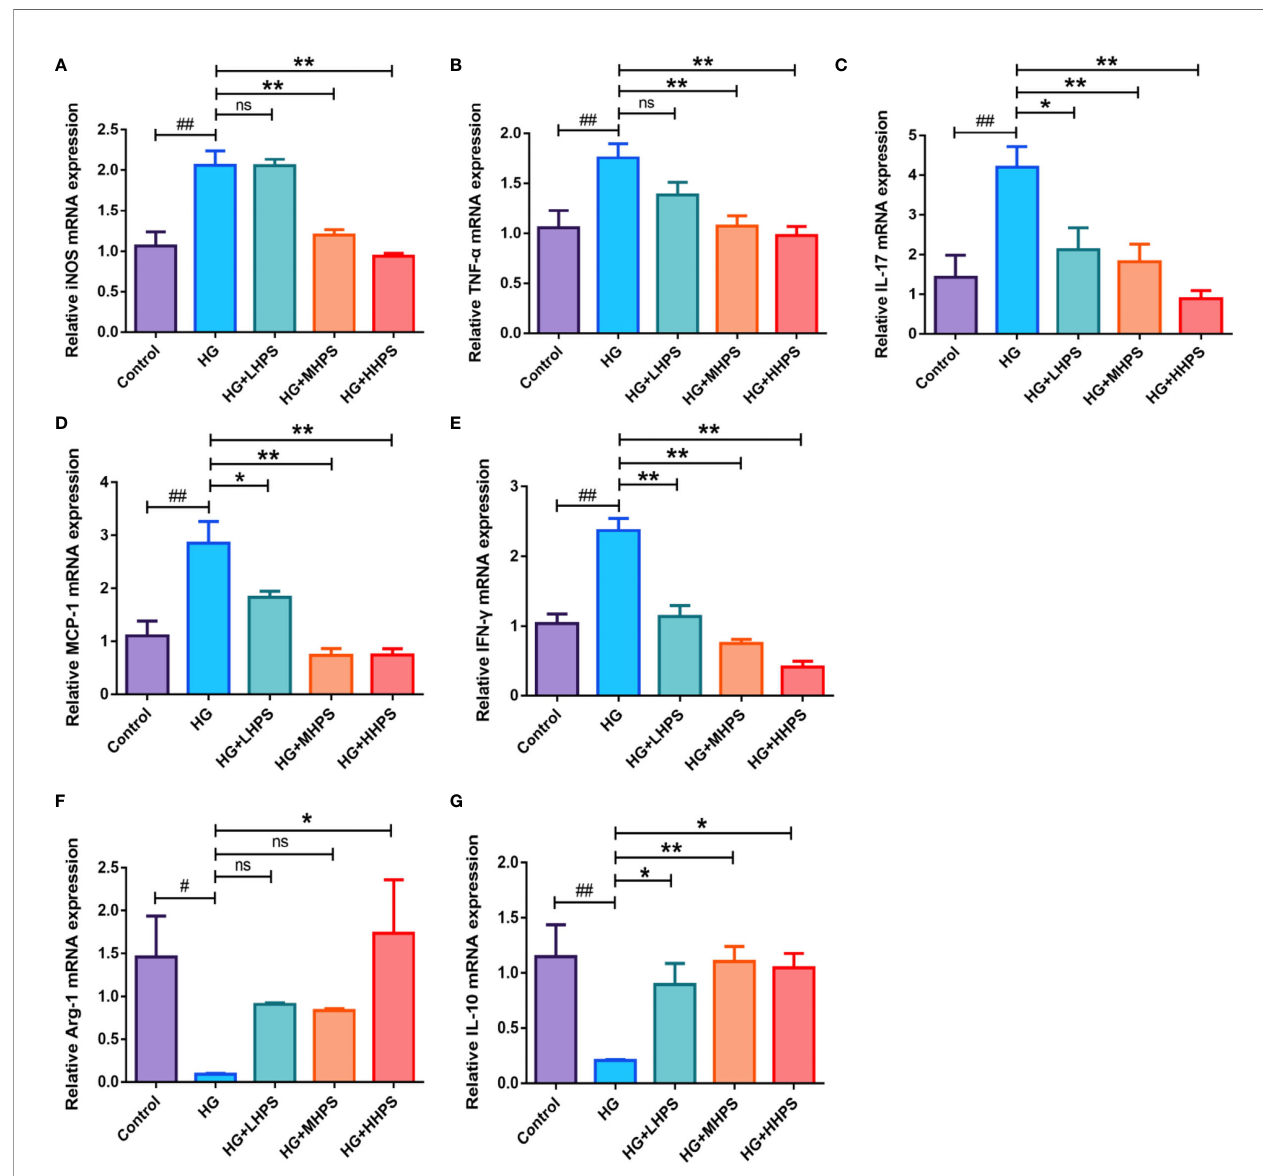
FIGURE 8 | Effects of Hyperoside on the gene expressions of the proin fl ammatory and anti-in fl ammatory cytokines in high glucose (HG)-induced BMDMs. BMDMs were treated with high glucose (35mM) for 48 hrs, followed by pretreatment with high-dose HPS (HHPS) (50uM) or low-dose HPS (LHPS) (12.5uM), and then related mRNA expression was determined by qRT-PCR. Relative mRNA expressions of the proin fl ammatory cytokines iNOS (A) , TNF- a (B) , IL-17 (C) , MCP-1 (D) and IFN- g (E) , and anti-in fl ammatory cytokines Arg-1 (F) and IL-10 (G) were shown. Values are presented as means ± SD with n = 5 per group. Differences between experimental groups were evaluated using ANOVA ( # P < 0.05 and ## P < 0.01 vs Control; * P < 0.05 and ** P < 0.01 vs HG; ns, not signi fi cant). HG, high glucose treated group; HG+LHPS, high glucose and low dose of HPS treatment group; HG+MHPS, high glucose and middle dose of HPS treatment group; HG+HHPS, high glucose and high dose of HPS treatment